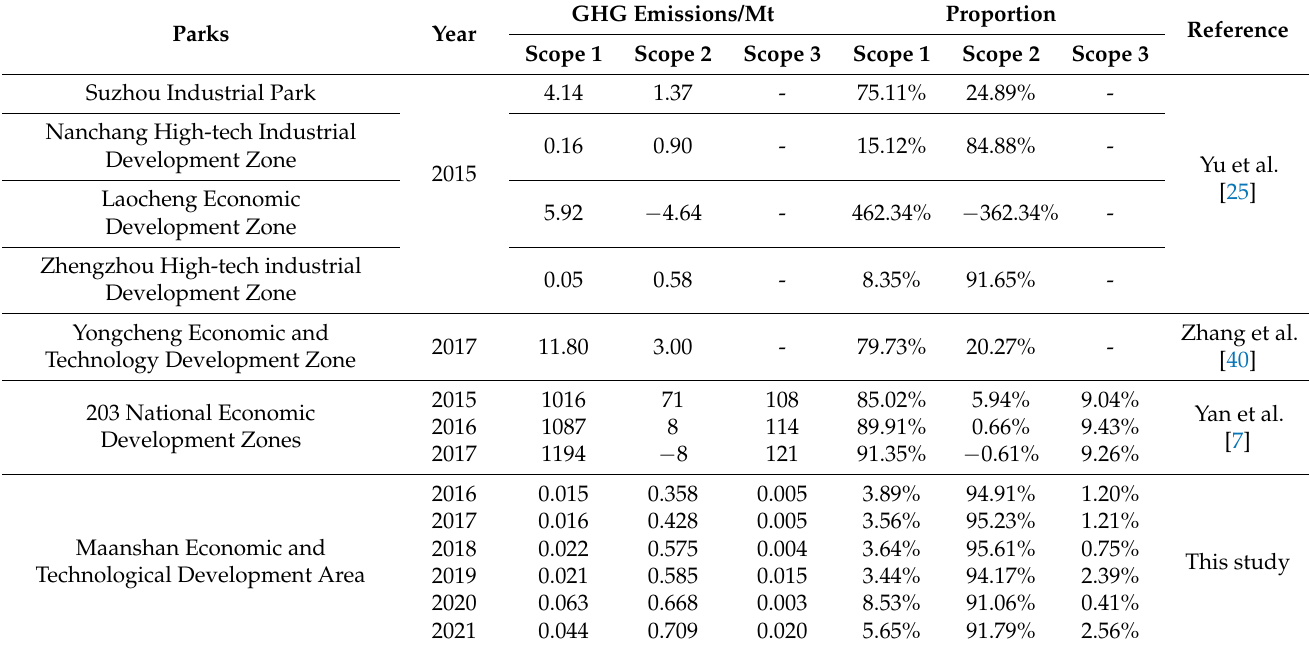
Table 1. Greenhouse gas emissions from the Scope 1 to 3 of other